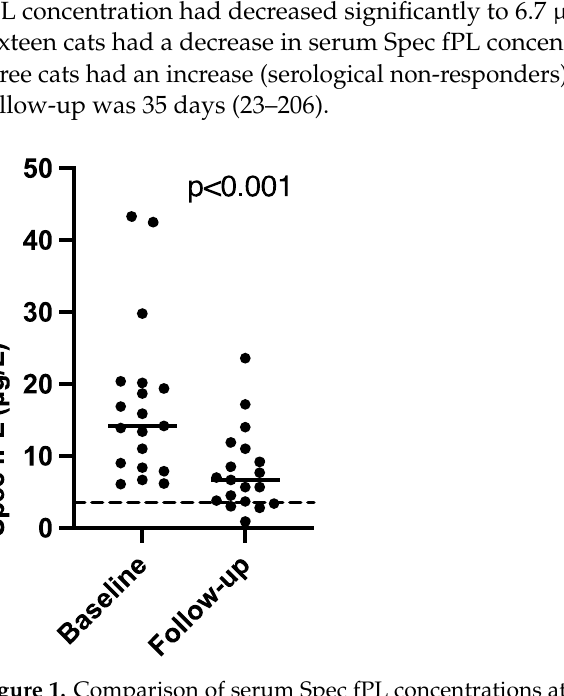
Figure 1. Comparison of serum Spec fPL concentrations at baseline and follow-up in 19 cats with presumed chronic pancreatitis treated with cyclosporine. Short horizontal lines represent median, long horizontal stippled line represents the upper limit of the serum Spec fPL reference interval (3.5 μ g/L).